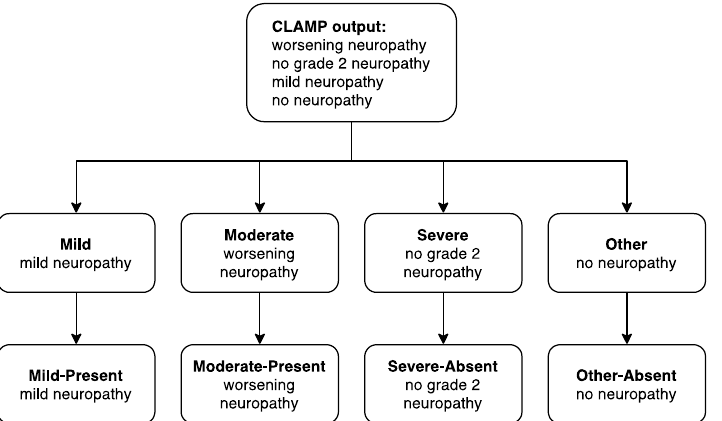
Figure A1. Flowchart showing the categorization of example neuropathy terms extracted by CLAMP from clinical notes.